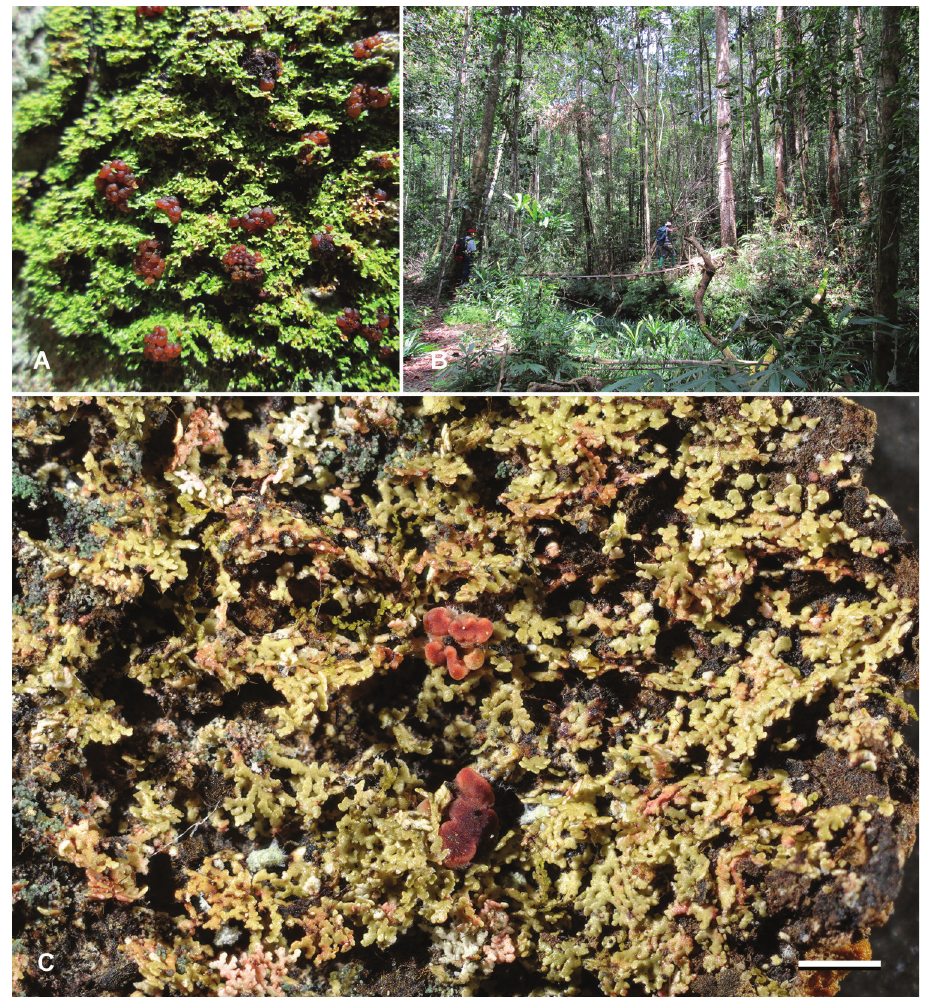
Figure 2. Krogia borneensis . A Field photograph of the holotype B habitat at type locality C herbarium photograph of holotype. Scale bar: 1 mm. Photo: H. Thüs ( A, B ), E. Timdal ( C